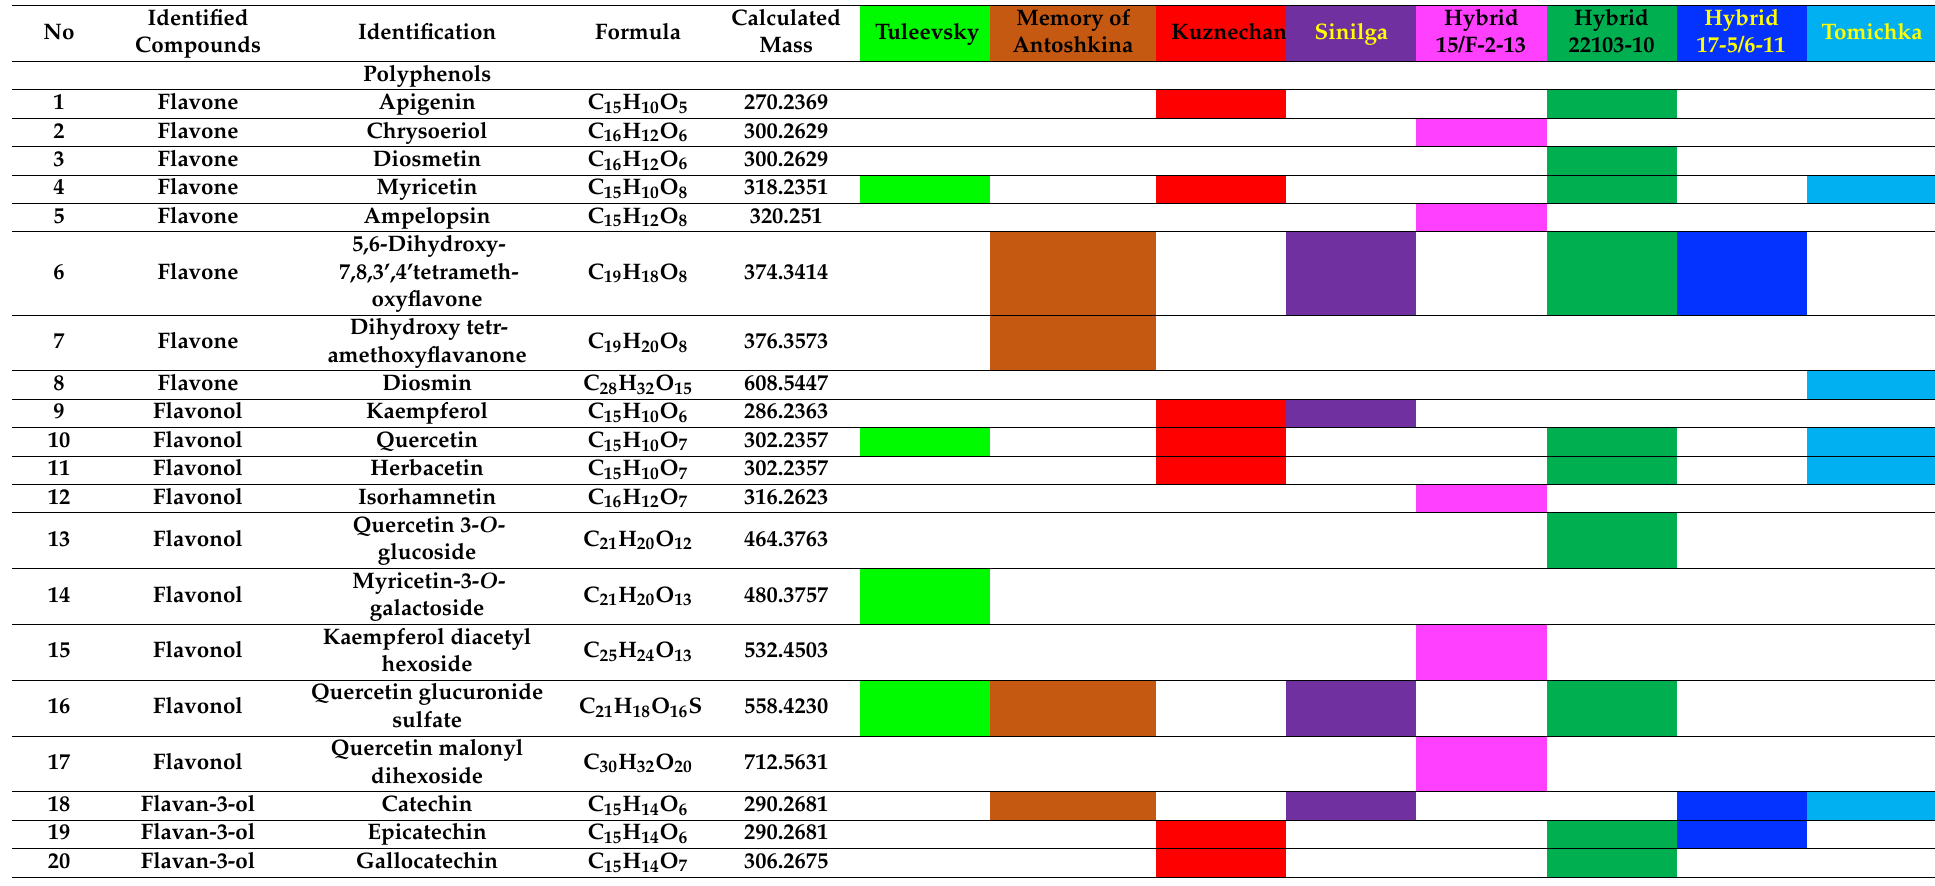
Table 2. The presence of identified compounds in different varieties of Siberian S. tuberosum (Variety Tuleevsky—light green; variety Memory of Antoshkina—brown; variety Kuznechanka—red; variety Sinilga—violet; variety Hybrid 15/F-2-13—rose; variety Hybrid 22103-10—green; variety Hybrid 17-5/6-11—blue; variety Tomichka—light